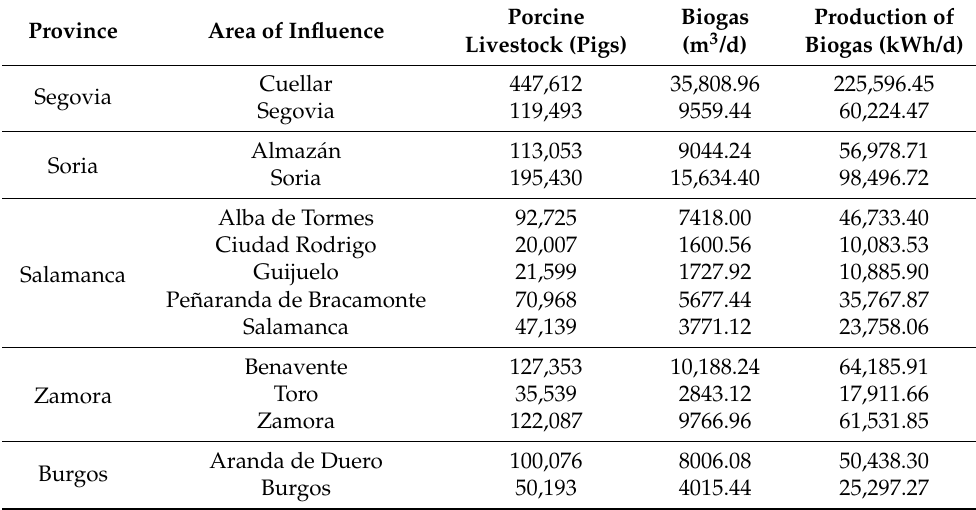
Figure 3. Areas of influence of 25 km from the municipalities with higher energy demand. Table 1. Porcine livestock census of the studied